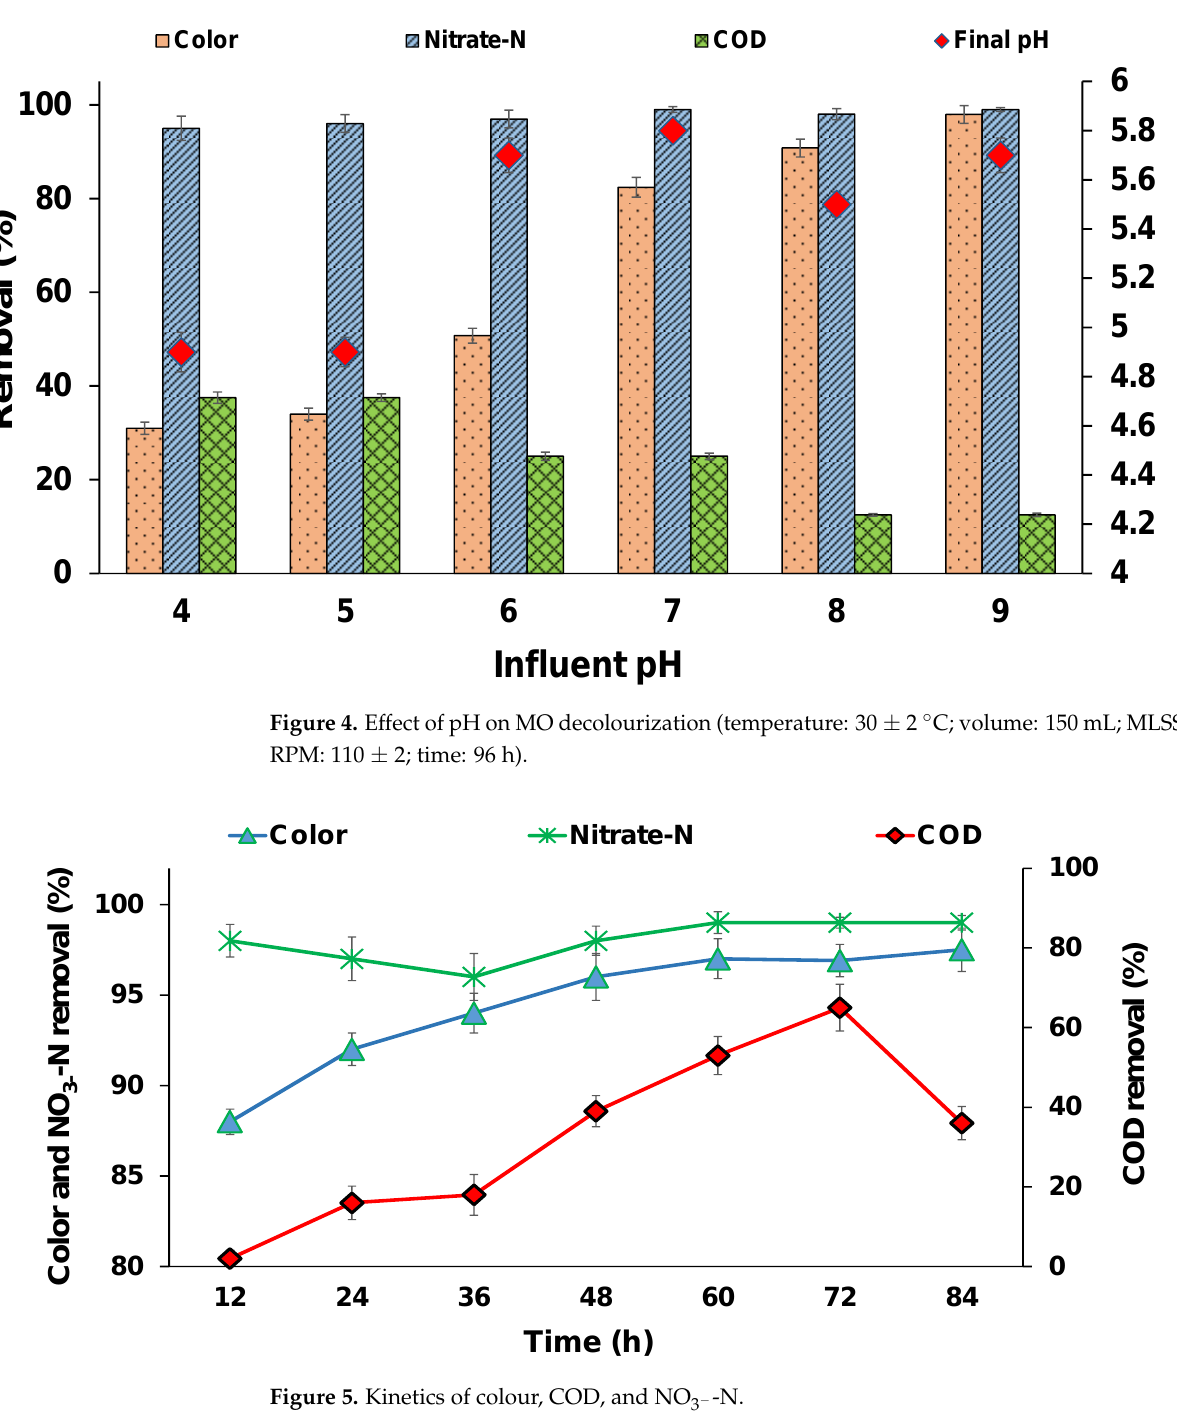
Figure 5. Kinetics of colour, COD, and NO 3 − -N.